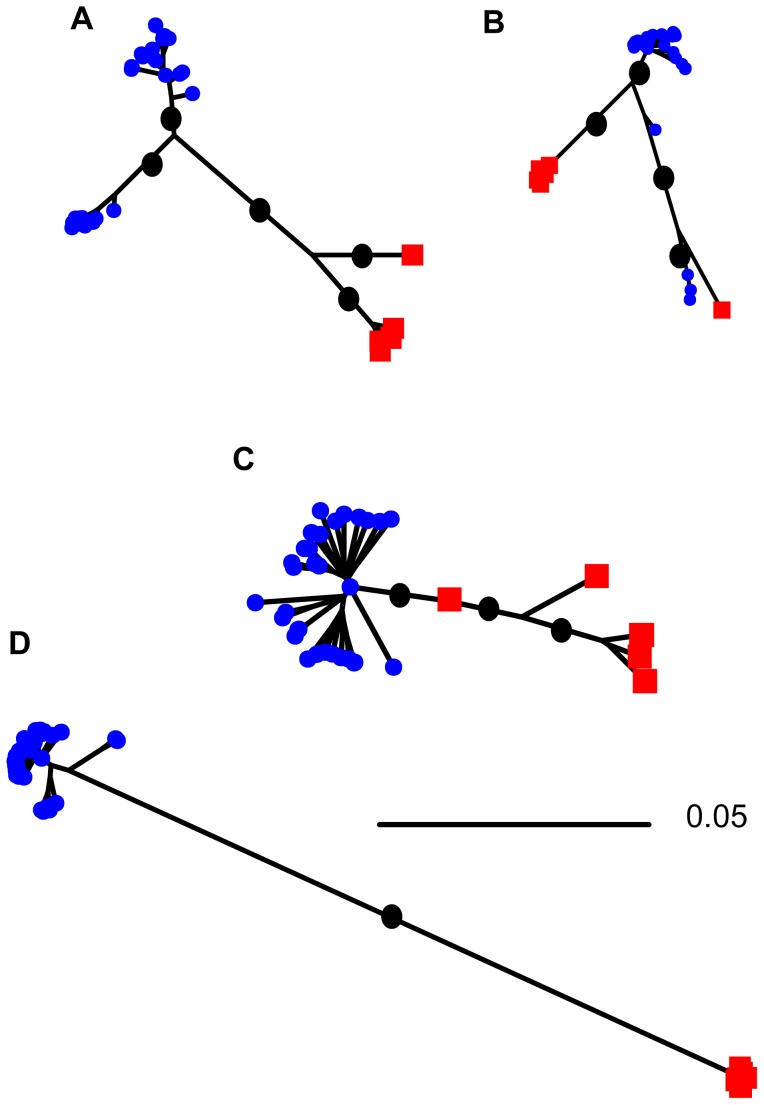
Neighbor-joining trees showing relationships among sequences sampled from S. meliloti (blue squares) and S. medicae (red circles) for genes showing evidence of horizontal gene transfer.The largest three regions of transferred genes are shown A) 11 genes from pSMED02, concatenated length of 9,291 bp, B) 69 genes from pSMED02, concatenated length of 69,048 bp, C) 23 genes from pSMED01, concatenated 22,493 bp, and D) genes on pSymB for which there was no evidence of horizontal transfer between species (944 genes concatenated 977,757 bp). Black dots indicate major branches with bootstrap support >95%, bootstrap support for shorter branches within single-species clades not shown.